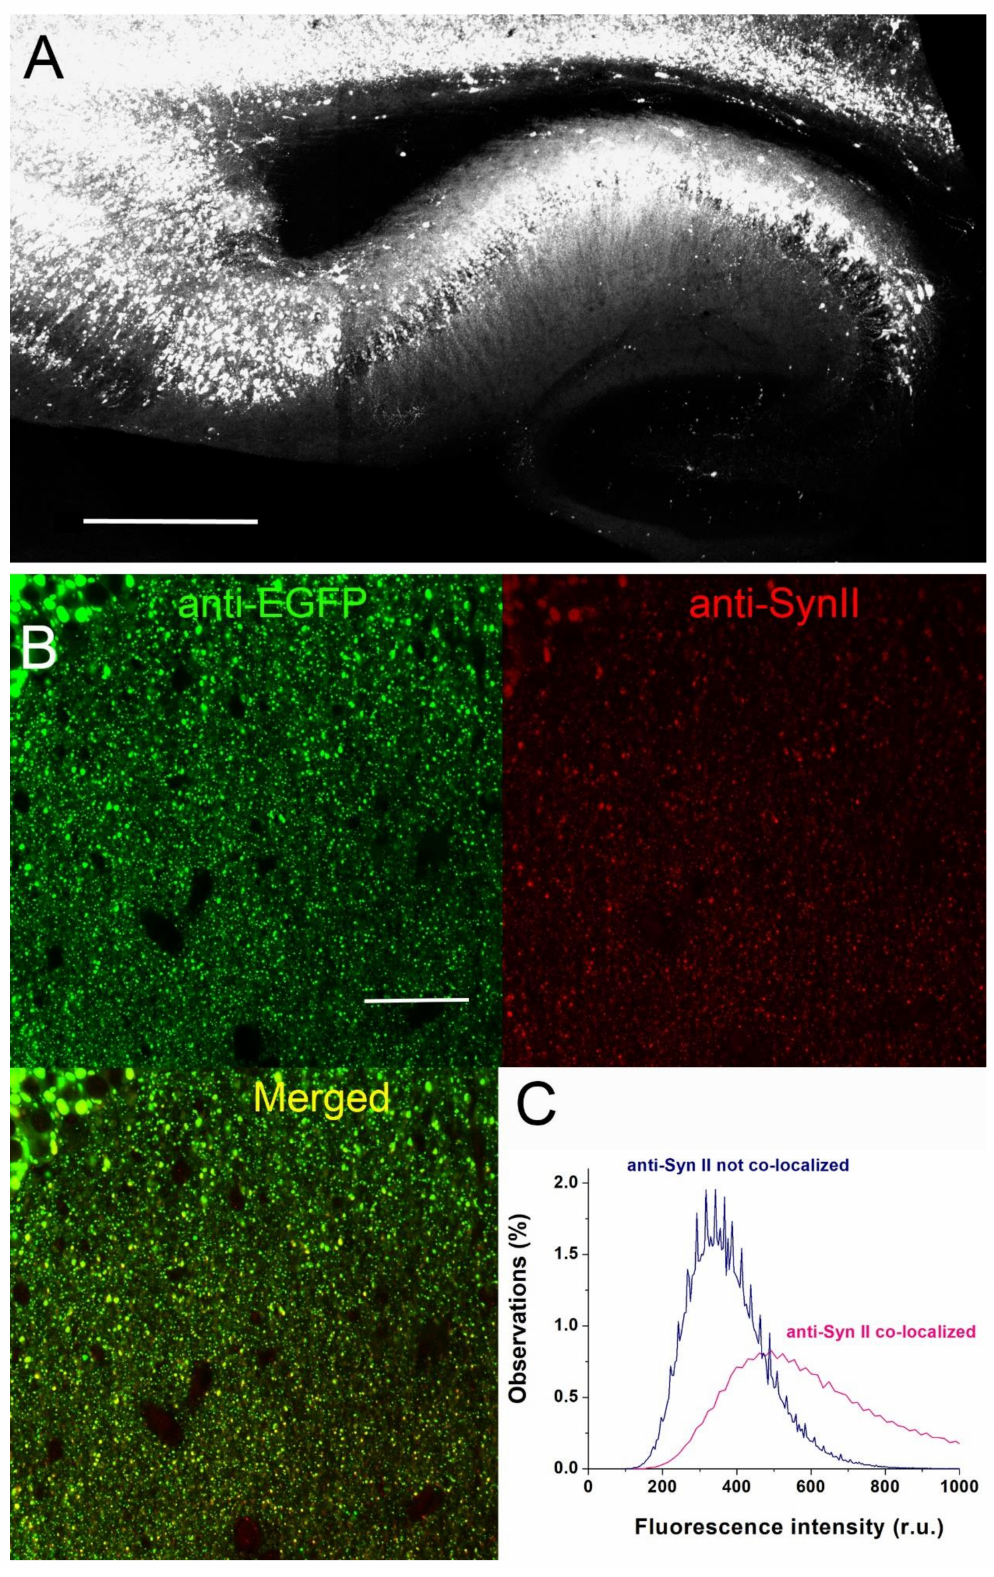
Figure 2. Expression of SynII-TurboGFP in the hippocampus of AAV-injected mice. ( A ) SynII- TurboGFP expression in the hippocampus and cortex after neonatal ICV injection of